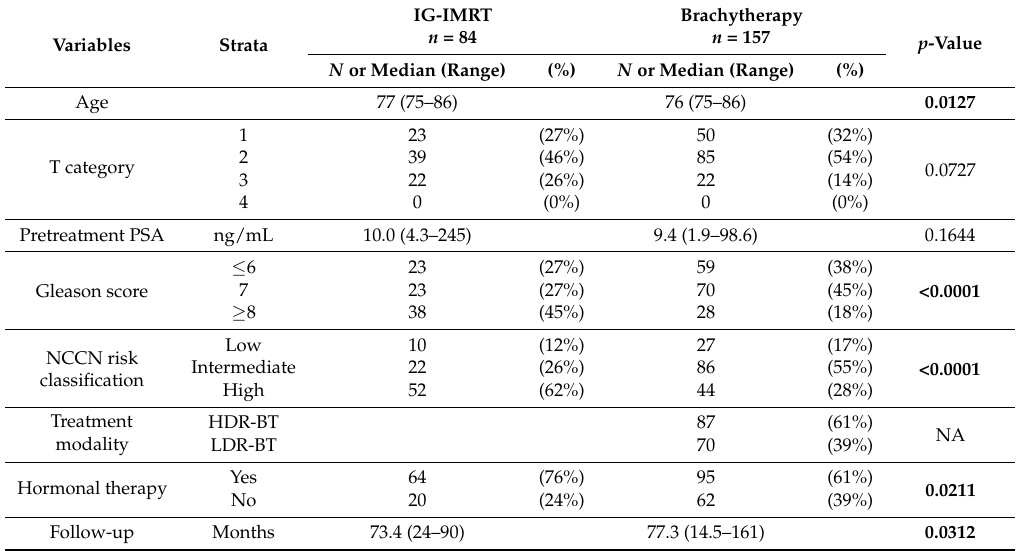
Table 4. Characteristics and treatment factors of elderly patients according to